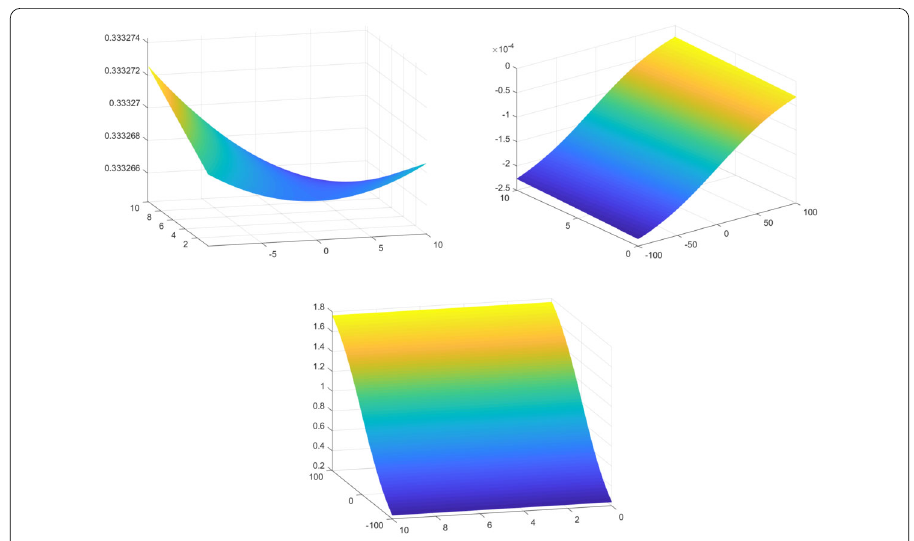
Figure 2 The graph of u ( x , t ), v ( x , t ), andw ( x , t ) when α = c 1 = c 0 = 1, k = 0.01 and β =